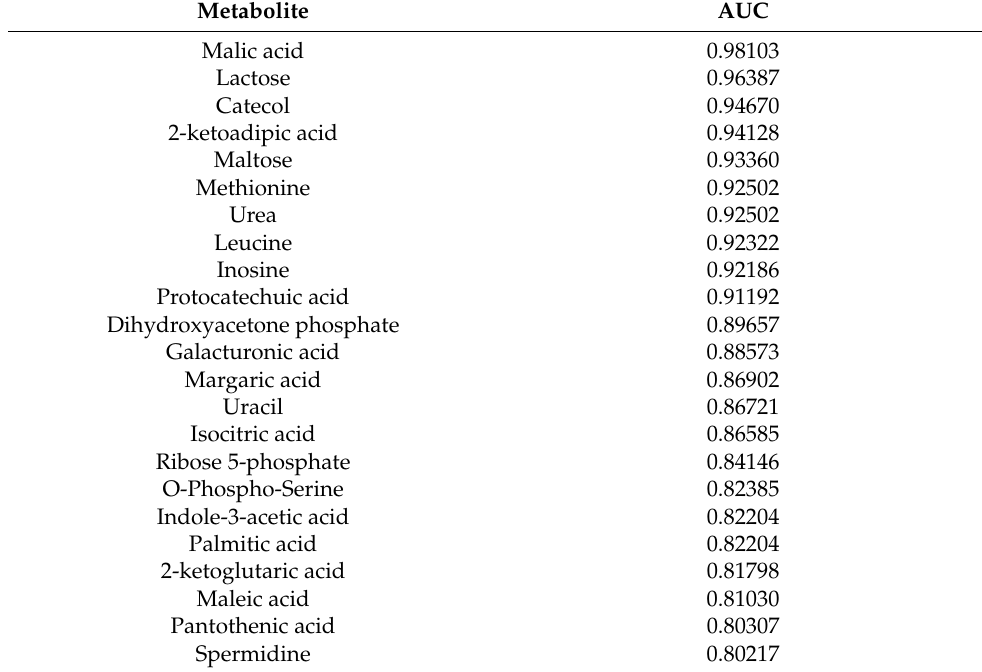
Table 5. Area Under the Receiving—Operator Curve (AUC) for possible OSCC salivary